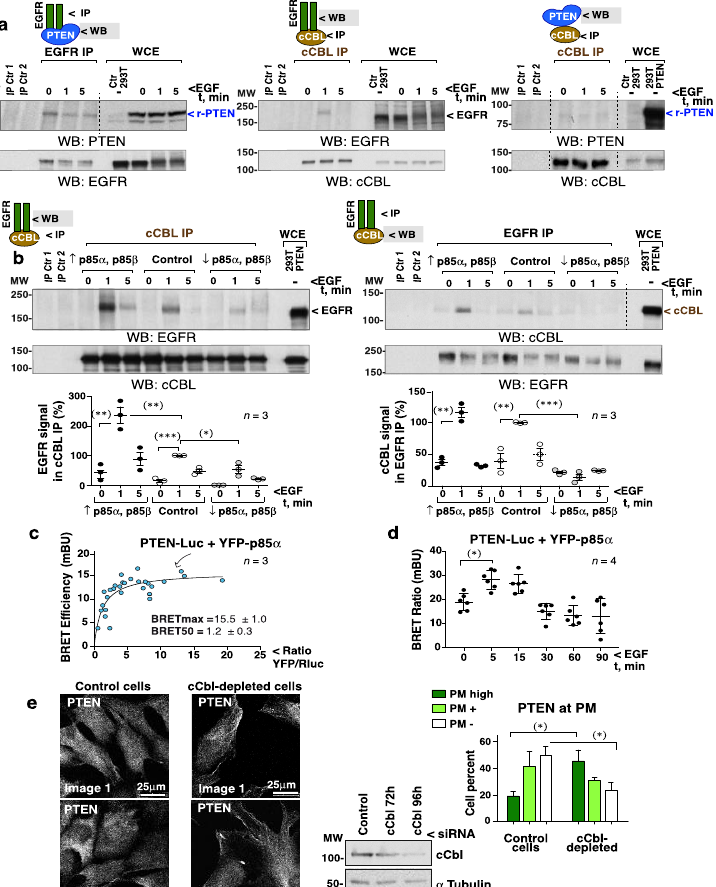
Figure 7. EGFR associates with cCBL in a PI3-kinase-dependent manner. ( a , b ) HEK-293T cells were transfected with PTEN-Luc alone (48 h) ( a ), or with a mixture of PTEN-Luc, HA-p85 α , and HA-p85 β cDNA (48 h) (indicated as ↑ p85 α , p85 β ), or were first transfected with a mix of PIK3R1 (p85 α ) plus PIK3R2 (p85 β ) siRNA (72 h) and then with PTEN-Luc (last 48 h) ( ↓ p85 α , p85 β ) ( b ). The efficiency of these transfections was tested by WB (Supplemental Figure S7b). Cells were then incubated in serum-free medium (2 h) and stimulated with EGF (100 ng/mL). NP-40 or Brij96 extracts (1 mg) were used for EGFR and cCBL IP, respectively. For controls, Prot A or G were incubated with Ab (IP Ctr 1) or lysate (IP Ctr 2). The presence of associated proteins in EGFR or cCBL immunoprecipitates were examined by WB. The last lanes show control WCE (indicated). The graphs ( b ) show the EGFR signal in cCBL IP, corrected for the cCBL content and normalized to the maximum EGFR signal in complex with cCBL (control at 1 min, 100%) (mean ± SD, n = 3). The graph for the cCBL signal in EGFR IP was similarly plotted ( n = 3). ( a , b ) Dashed lines indicate the cutting out of lanes from the original blots (included as Supplementary Information). * p < 0.05, ** p < 0.01, *** p < 0.001, Student’s unpaired t test. ( c ) BRET saturation curves in HEK-293T cells transfected with a constant amount of PTEN-Luc and increasing amounts of YFP-p85 α . Data were fitted to a non-linear regression equation assuming one binding site ( n = 3). FRETmax/BRETmax and FRET50/BRET50 values (mean ± SD) were calculated using a non-linear regression equation ( n = 3). ( d ) BRET efficiency in HEK-293T cells transfected with a fixed 1:1 amount of PTEN-Luc and YFP-p85 α (48 h) and stimulated with EGF (100 ng/mL) for the indicated times (mean ± SD, n = 4) (*) one-way ANOVA. ( e ) Exponentially growing control and cCbl-depleted NIH3T3 cells (72 h) were transferred to glass coverslips (24 h) prior to the IF detection of PTEN (two representative images, each). Blots confirmed cCbl depletion efficiency. The graph illustrates the percentage of cells (mean ± SD, n = 100 cells) with an intense, positive, or negative PTEN PM signal (indicated). * p < 0.05, ** p < 0.01 Student’s unpaired t